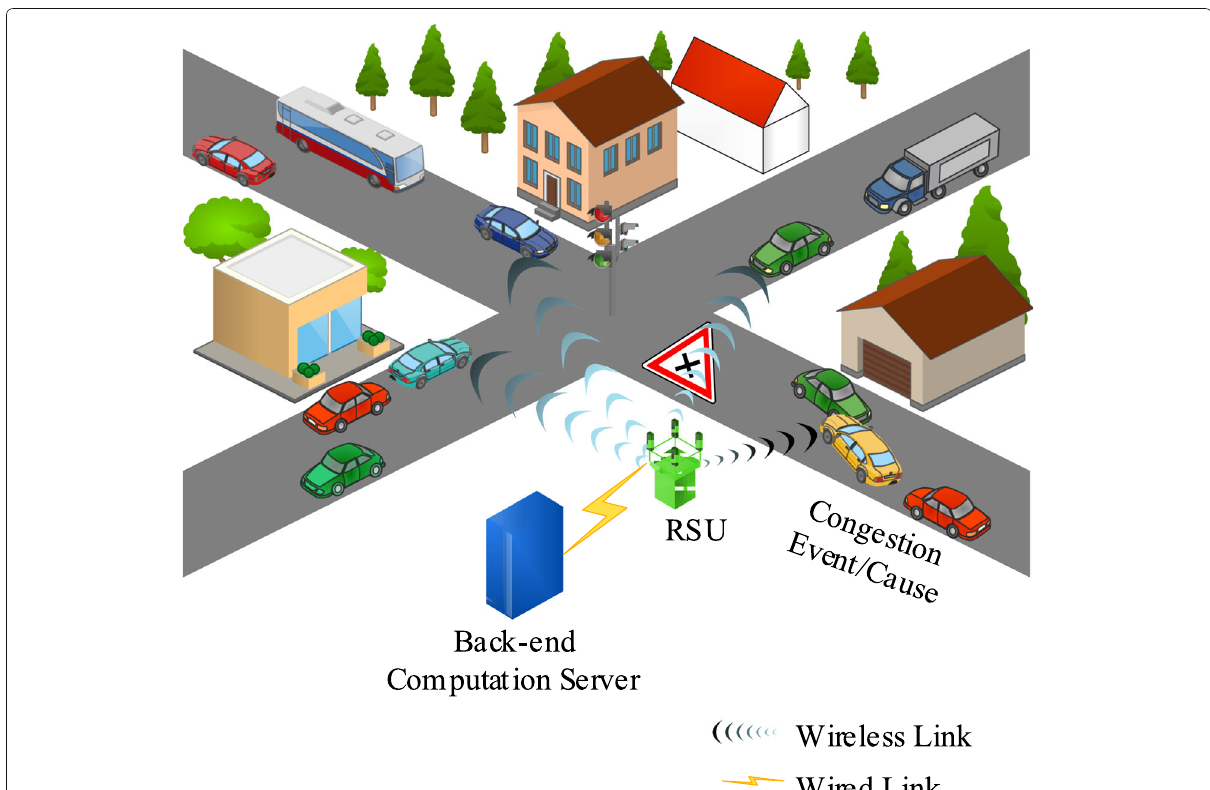
Fig. 6 VCC—Application as a Service Usage of vehicular cloud network to support applications such as road safety, traffic density, and